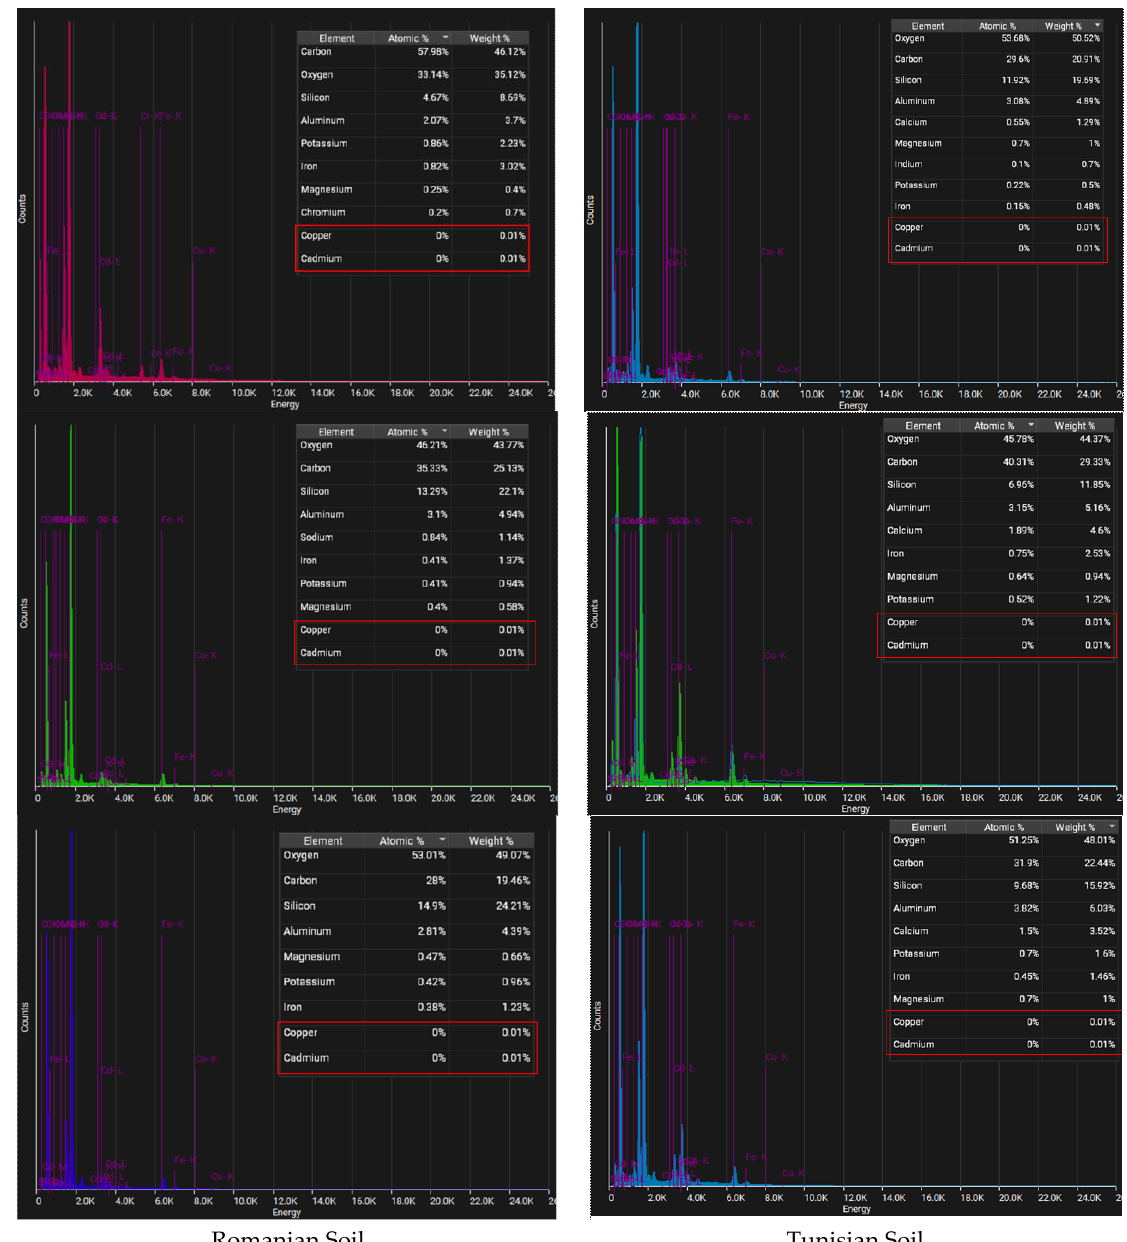
Figure 2. Elemental analysis of Tunisian soil before adsorption process.